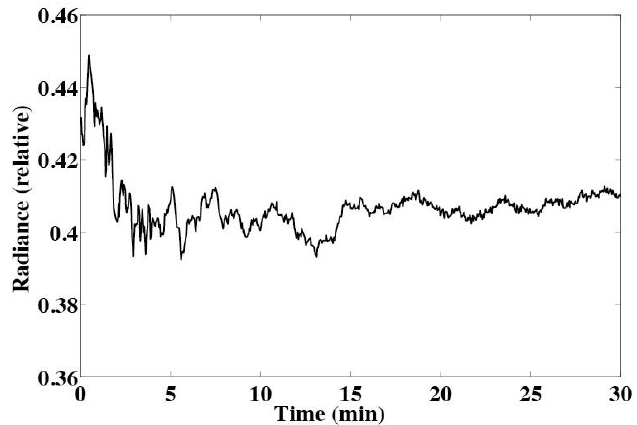
Figure 4 . Radiance at 425 nm of blue LED over time. The LED should be allowed to run for at least 1.5 minutes to allow the output to stabilize.